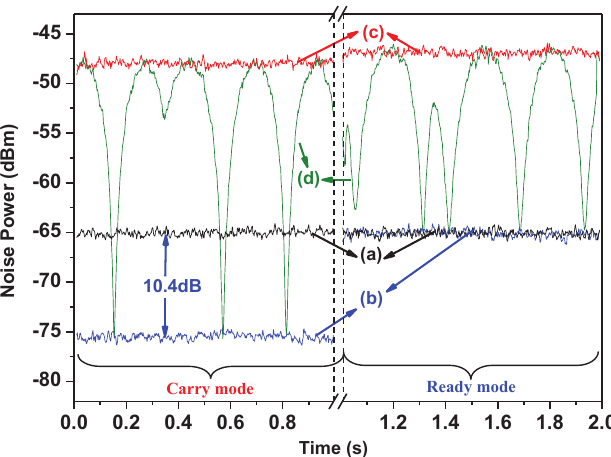
Figure 5. Balance homodyne measurements of the quadrature noise variances at a Fourier frequency of 500 kHz, with an RBW of 10 kHz and a VBW of 20 Hz. The data contained electronic noise and represent direct